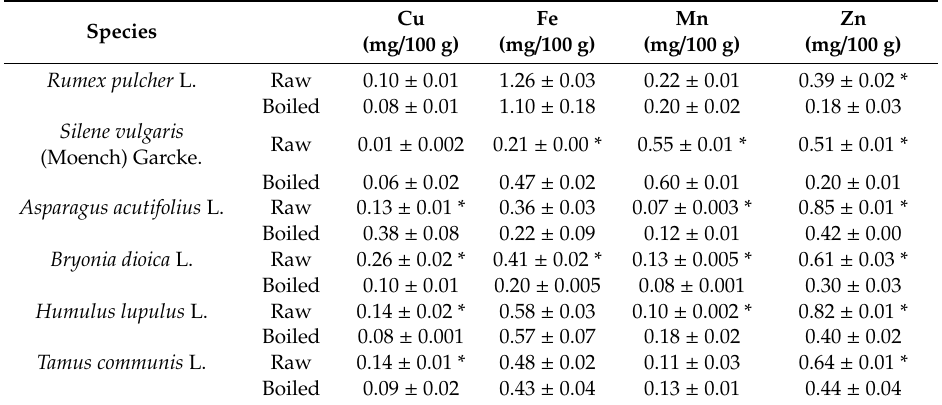
Cu Fe Mn Zn (mg / 100 g) (mg / 100 g) (mg / 100 g) (mg / 100 g)